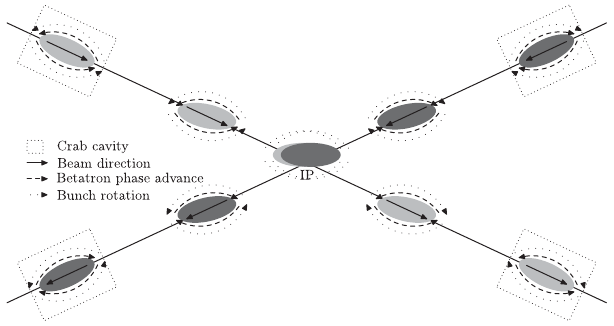
FIG. 1. Local crab crossing scheme showing creation of “ crab bump. ”